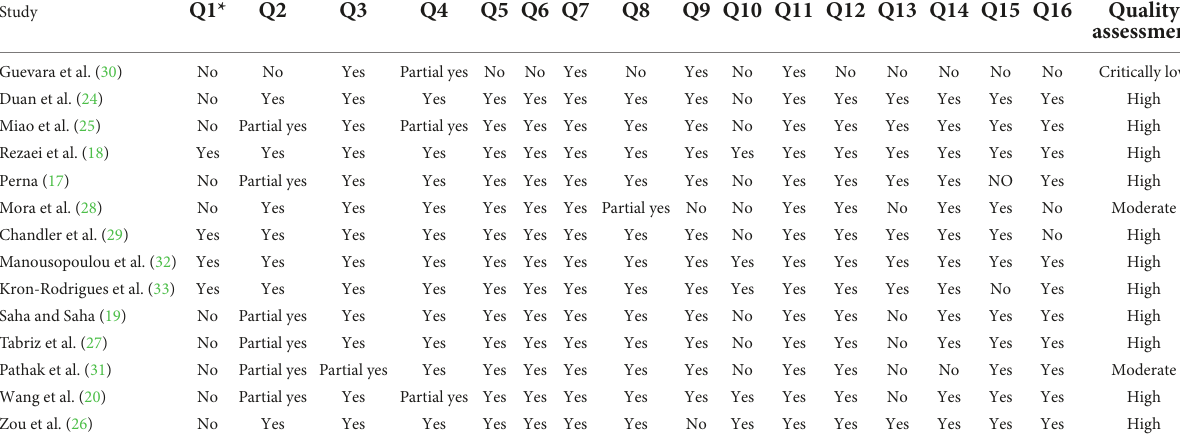
TABLE 2 Results of assess the methodological quality of